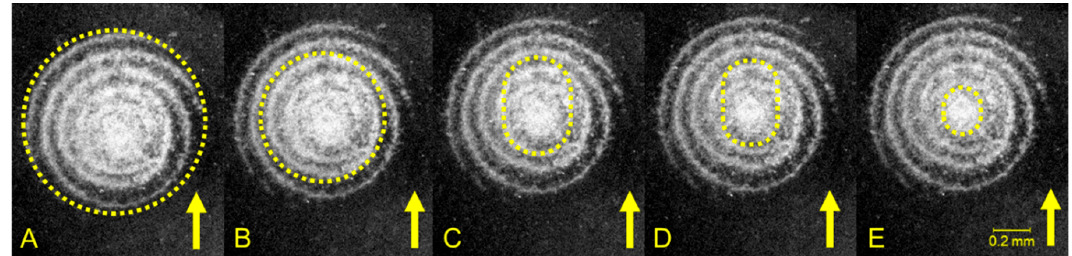
Figure 10. Upper: Change of contact area and friction force within the stick-slip behavior of the first trace in the 5 µm/s test; Lower: Changing rate of contact area and friction force within the stick-slip behavior of the first trace in the 5 µm/s test.